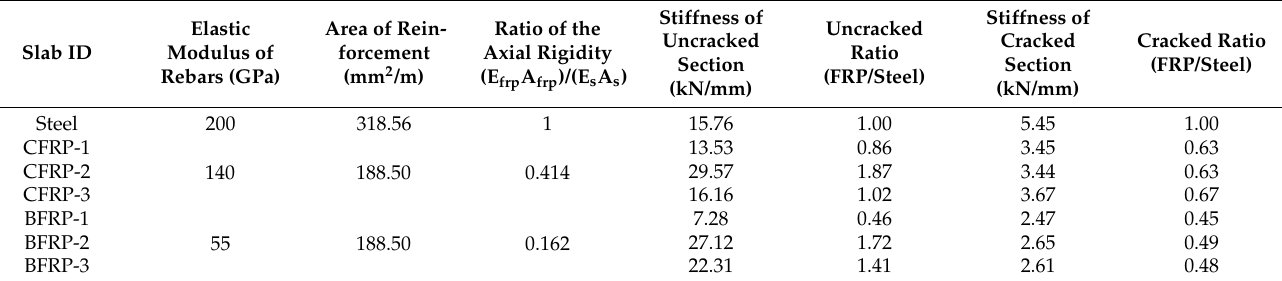
Table 3. Stiffness of all test slabs.